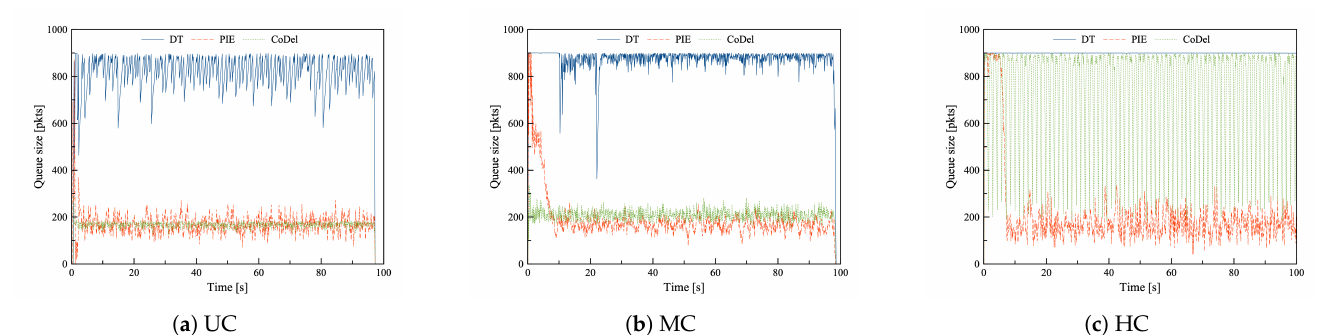
Figure 8. The queue length of DT, PIE and CoDel in combination with mix TCP flows in the Data Center scenario ( a ) in uncongested network, ( b ) during mild congestion, ( c ) during heavy